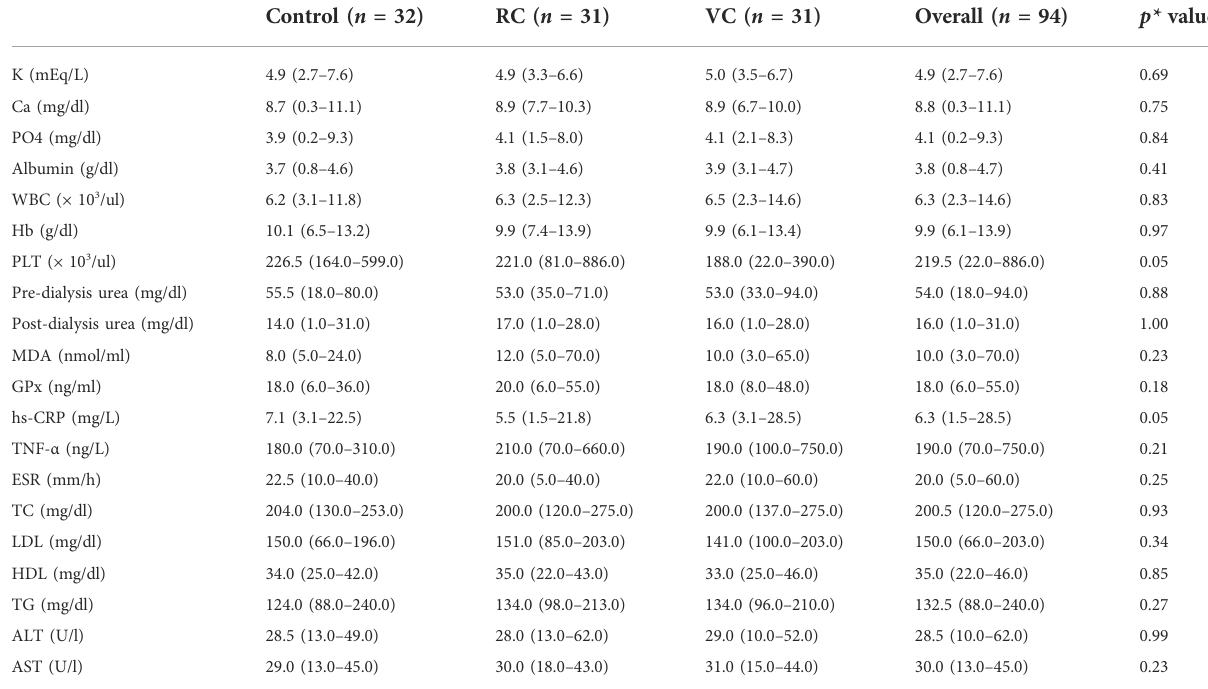
TABLE 2 Baseline values of laboratory ’ measurements of the studied